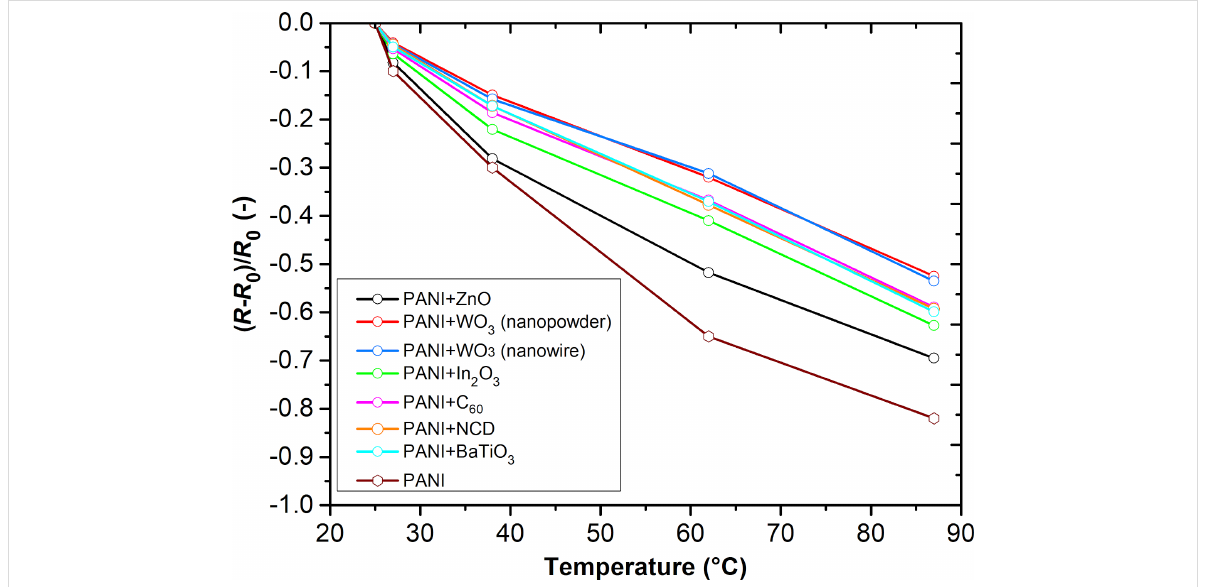
Figure 4: Temperature dependence characteristics of active layers.